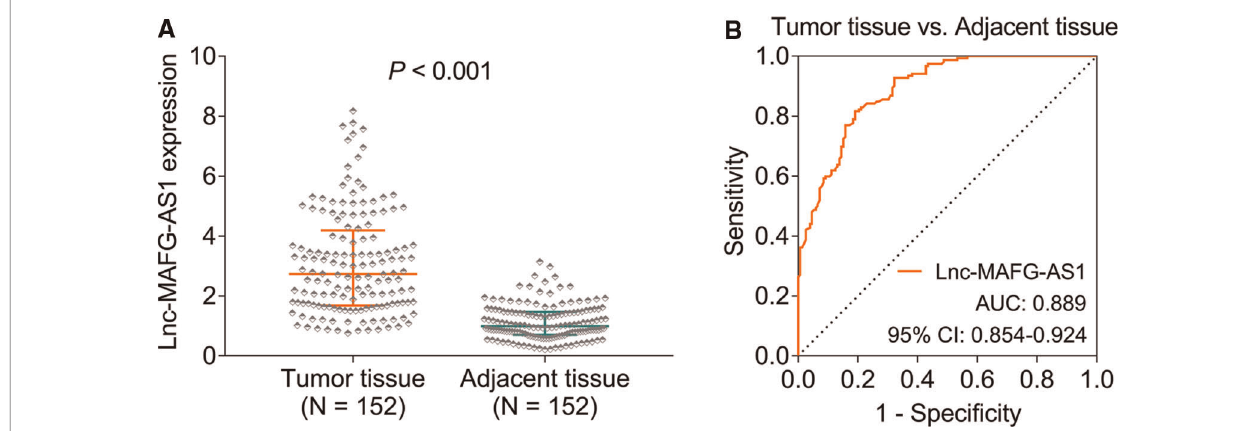
FIGURE 1 | Long non-coding RNAs musculoaponeurotic fi brosarcoma oncogene family, protein G antisense 1 (lnc-MAFG-AS1) expression. Lnc-MAFG-AS1 expression in hepatocellular carcinoma (HCC) tumor tissue and adjacent tissue ( A ). Receiver operator characteristic curve analysis of lnc-MAFG-AS1 expression for distinguishing HCC tumor tissue from adjacent tissue ( B